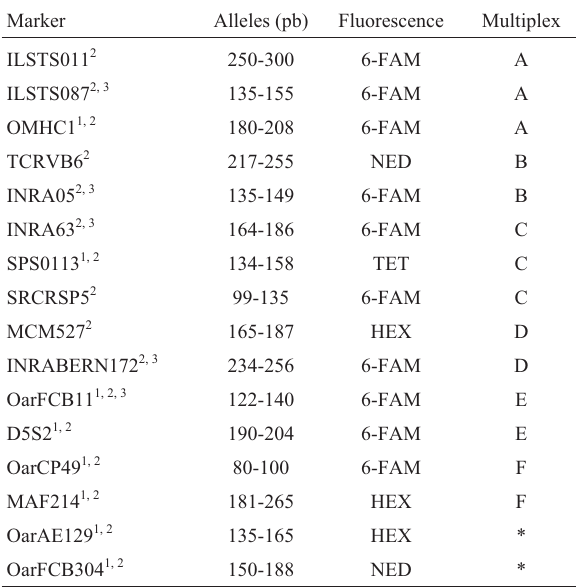
Table 1 - Marker code, expected allele size, type of fluorescence and mul-